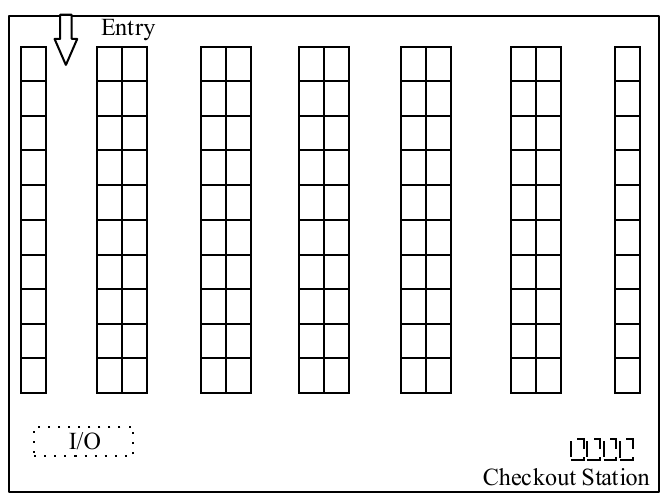
Figure 1. Retail store layout.